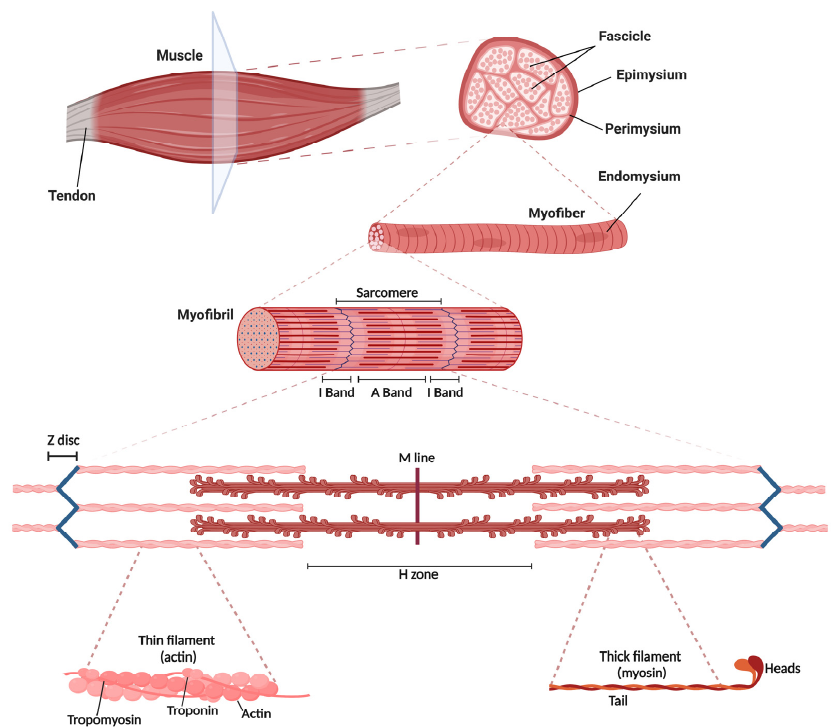
Figure 1. Structure of skeletal muscle, myofibers, and the sarcomere. The muscle is made up of several myofibrils packed into functional units surrounded by different layers of connective tissues (epimysium, perimysium and endomysium). One myofiber is composed of several sarcomeres, which is the main contractile unit mainly composed of protein filaments (myofilaments), namely myosin (thick filaments) and actin (thin filaments). The structure of the sarcomere presents dark and light bands, also visible with a light microscope. This is due to the alternated arrangement of the A bands (or anisotropic bands), the dark bands containing whole thick filaments, and the I bands (or isotropic bands), the light bands made up of only the thin filaments, located between two thick filaments. The Z disc across I bands demarcates the point of attachment between two adjacent actin filaments. The M line is considered the center of a sarcomere, whereas the H zone, which contains only myosin, is the area in between the M line and Z disc in resting conditions. Each myofibril is associated with troponin and tropomyosin, two regulatory proteins of muscle